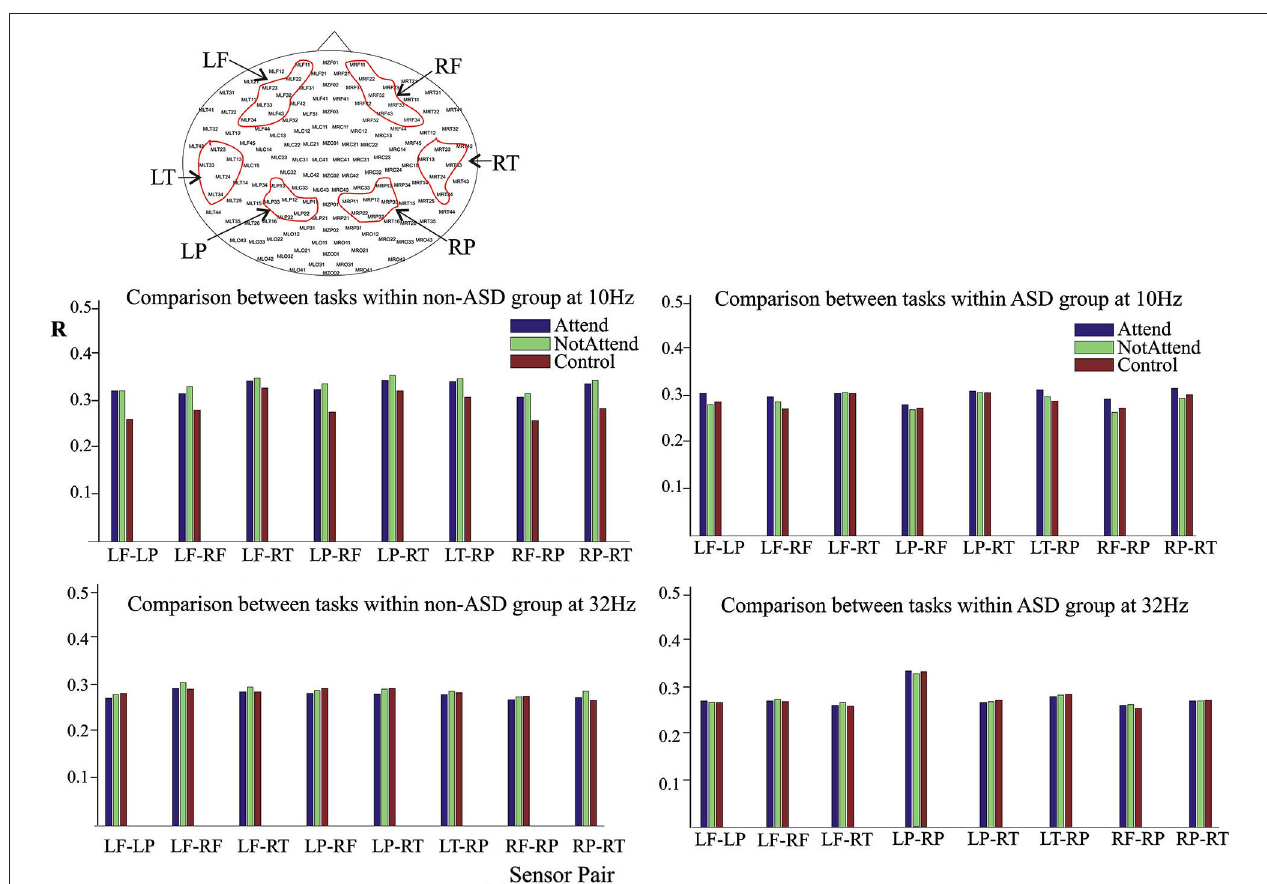
conditions of the task: the baseline (“control”) condition, the attend and no-attend to the deviant tone (“Attend” and “NotAttend” respectively). For clarity, eight sensor pairs are represented (same trend was present in the rest of combinations). Note the slight increase in synchrony during task performance, more evident in the non-ASD group, at central frequency of 10 Hz, in the upper bar graphs (see details in the Results